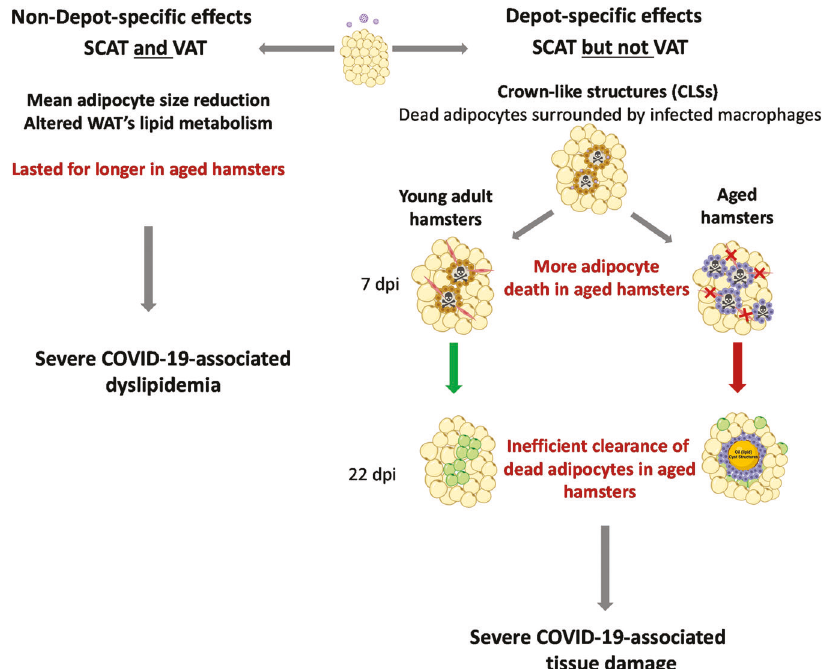
Fig. 7 Age-related differences in WAT ’ s response to SARS-CoV-2 infection in golden hamsters. Schematic diagram showing the non-depot- speci fi c (left) and the depot-speci fi c (right) effects of a SARS-CoV-2 infection on WAT in young-adult vs. aged golden hamsters. The viral infection perturbed lipid metabolism in both the (inguinal) SCAT and the (epididymal) VAT but induced CLS formation — indicative of infection-induced adipocyte death — in SCAT only. Importantly, massive adipose death was evident in the SCAT of aged hamsters. The repair phase post infection-induced injury was effective in young adults but not in aged animals. We hypothesize that the accumulation of tissue damage in the SCAT of aged animals results from both the defective clearance of dead adipocytes by surrounding macrophages having age- related compromised efferocytic capacity, and/or the absence of replacement of dead adipocytes by newly formed adipocytes due to age- related impaired adipogenesis. CLSs crown-like structures. Preadipocytes are shown in red, and newly formed adipocytes are shown in green. Both non-depot-speci fi c and depot-speci fi c WAT remodeling upon SARS-CoV-2 infection might participate to COVID-19 severity in aged individuals. Created with